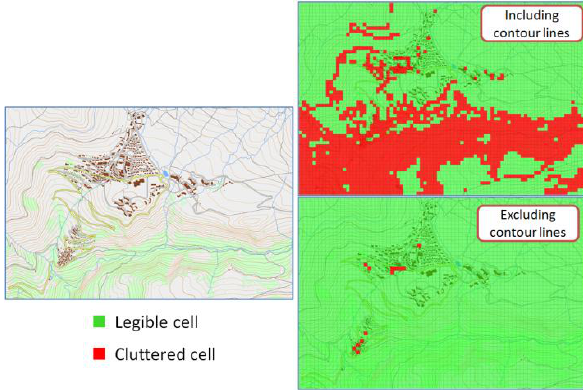
Figure 12. A vector based complexity method able to include or exclude background layers